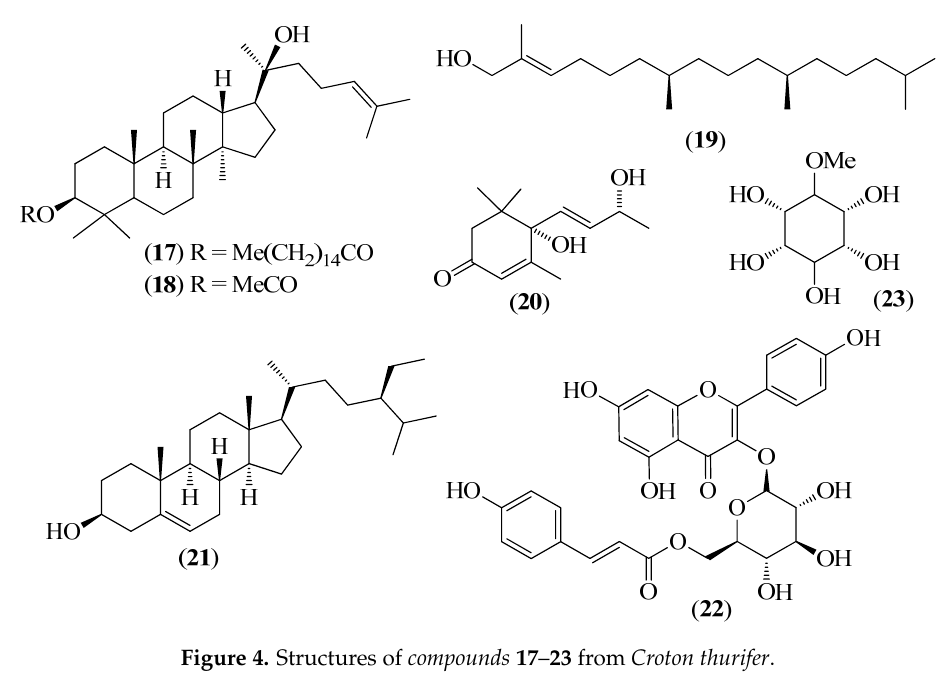
Figure 3. Structures of compounds 8 – 12 from Bejaria resinosa and 13 – 16 from Croton ferru- gineus .